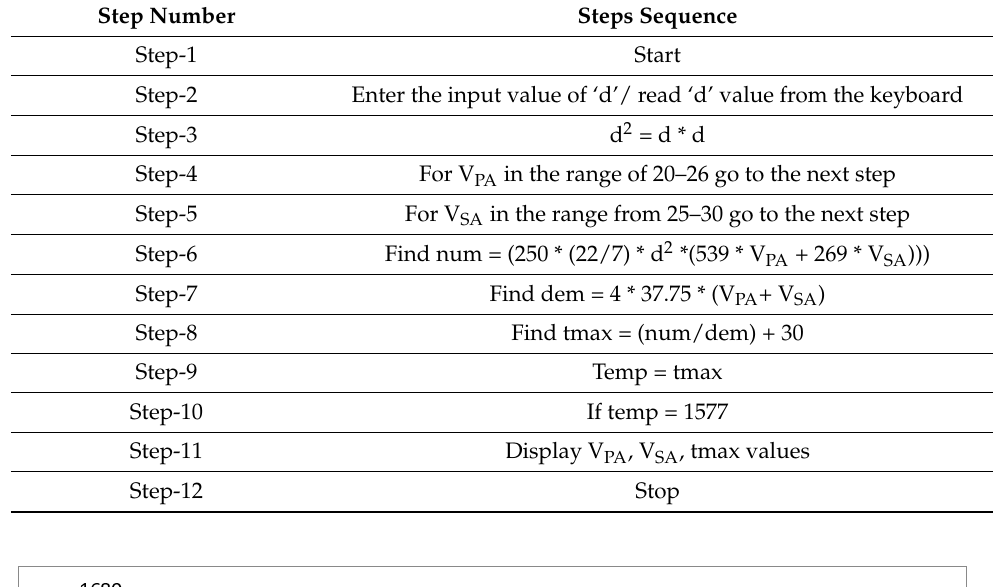
Table 11. Python programming algorithm.